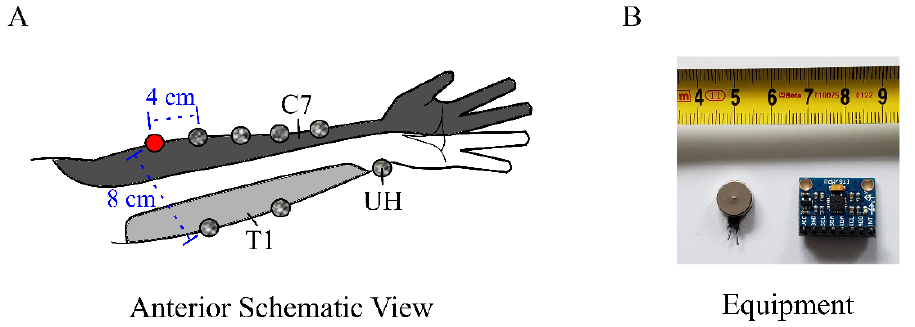
Figure 1. ( A ) Anterior view of the arm. Red marker indicates the source vibration. Gray markers